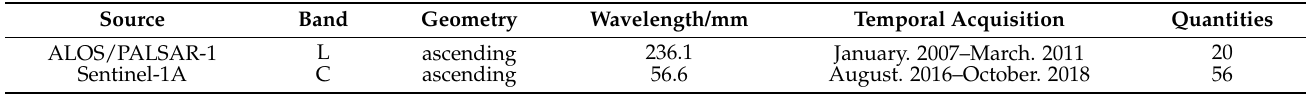
Table 1. Parameters of SAR datasets used in this study.